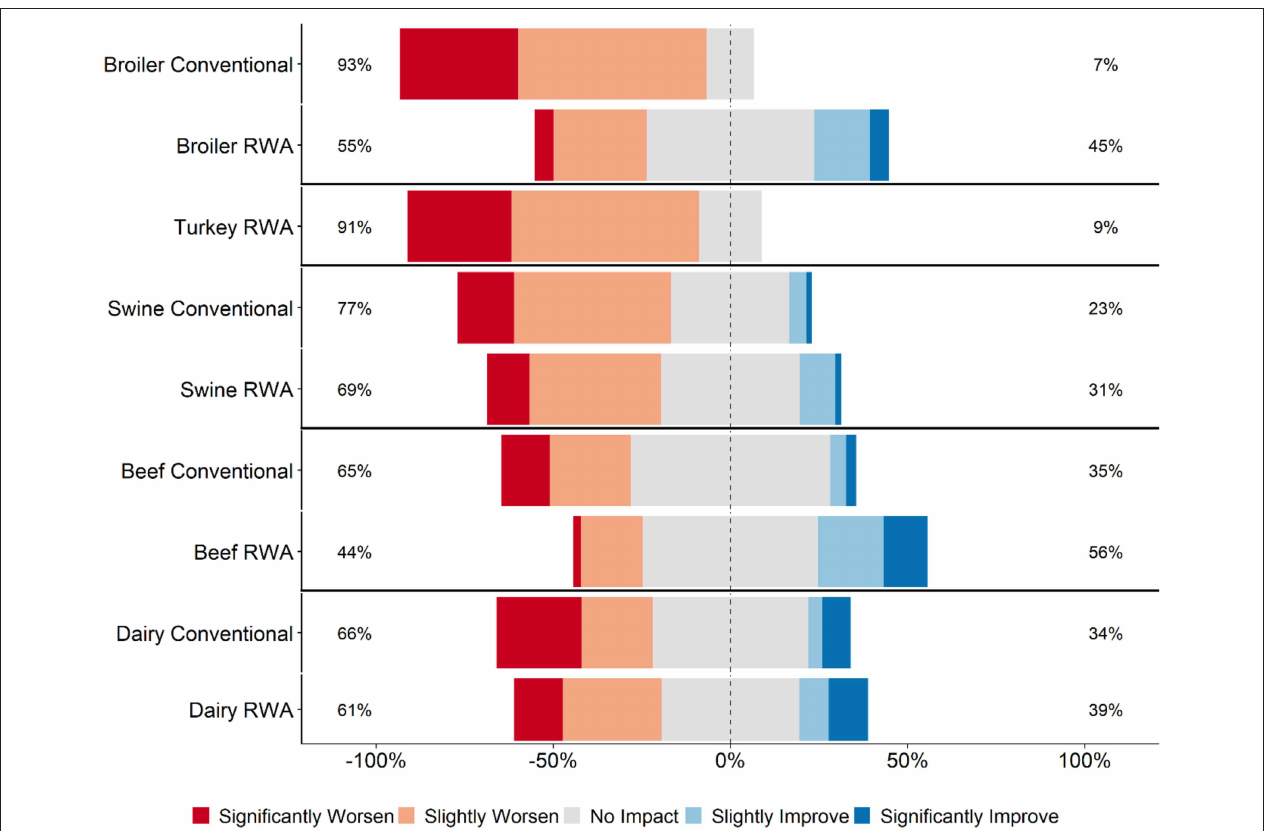
FIGURE 3 | Respondents’ opinion about the impact of RWA production on food safety. Five-item Likert scale reporting respondents’ opinion, stratified by commodity and RWA experience.